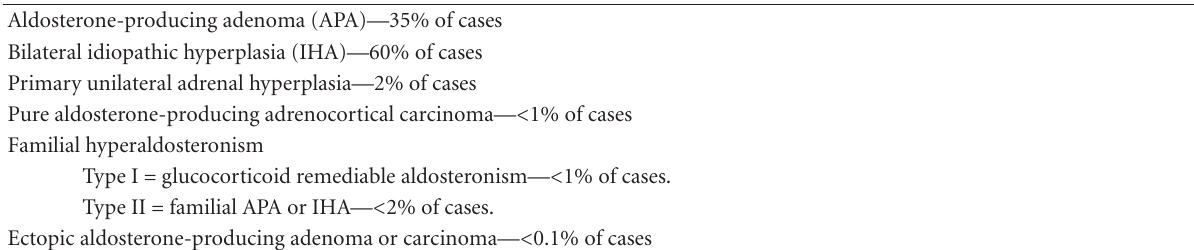
Table 1: Subtypes of primary aldosteronism